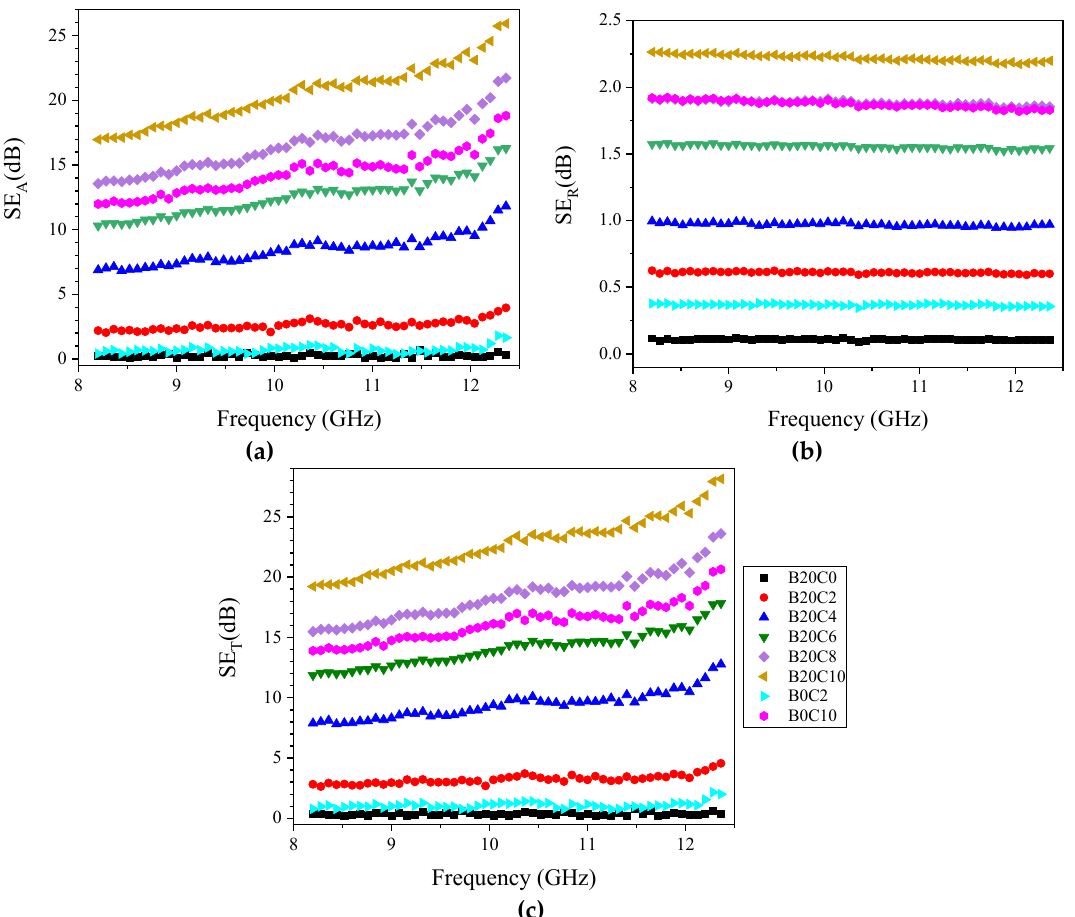
Figure 6. ( a ) SE A , ( b ) SE R and ( c ) SE T of the developed foams with 9 mm thickness within the X-band frequency.